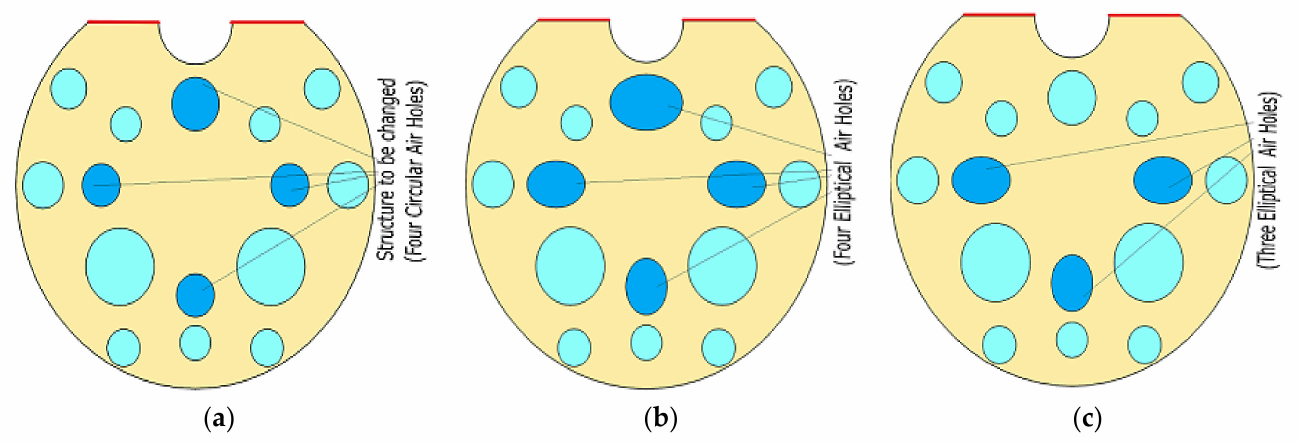
Figure 5. D-shaped PCF-based polarization filter with different air hole structure ( a ) all-circular air holes ( b ) with three elliptical air holes ( c ) with four elliptical air